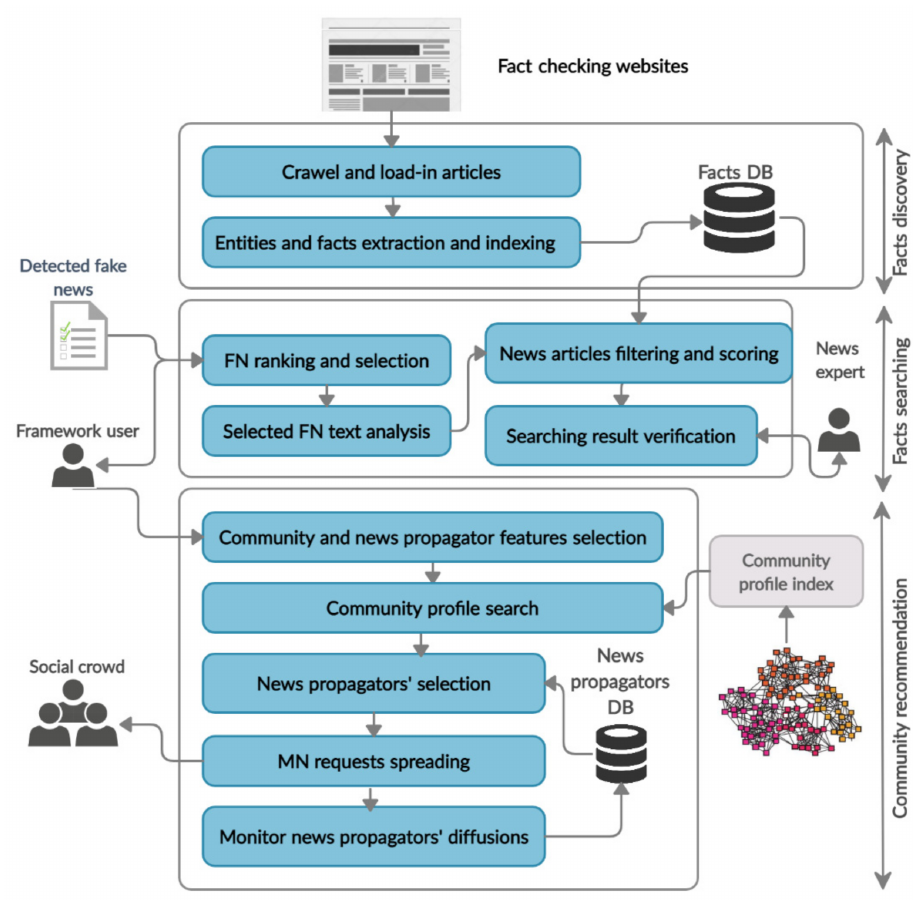
Figure 2. The community-based news mitigation